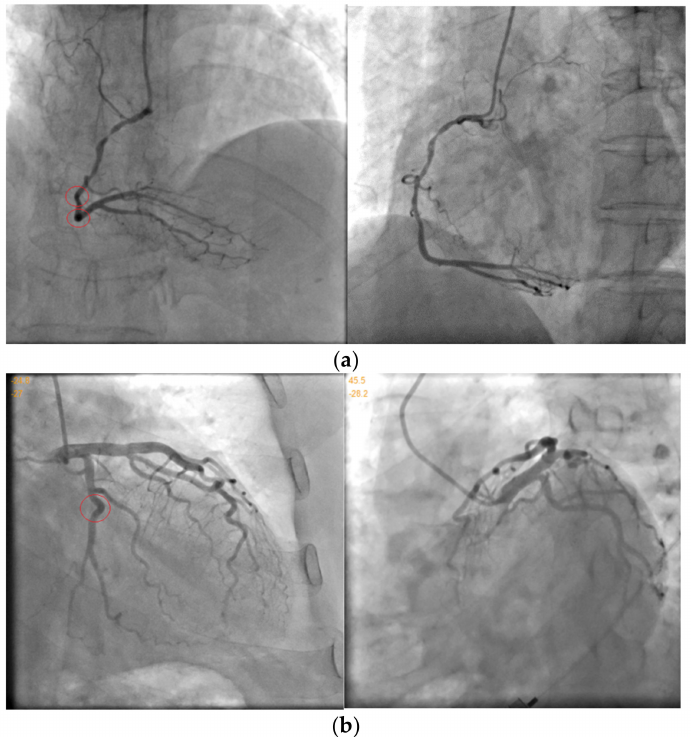
Figure 3. The example of OPE. ( a , b ) are two sets of patient data. The red circle on the left image is where OPE is; the image on the right is the